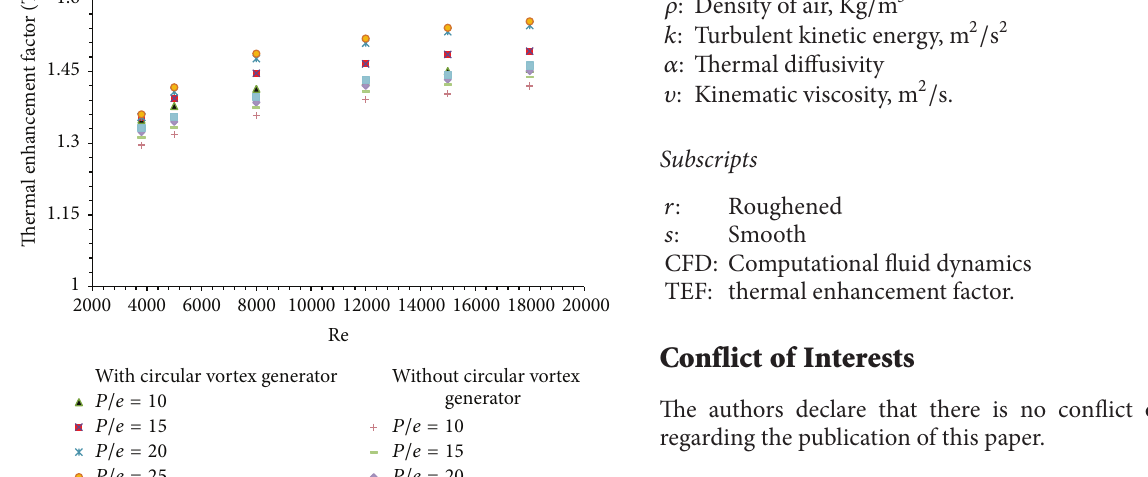
With circular vortex generator Without circular vortex P/e = 10